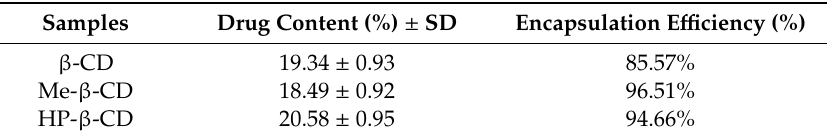
Table 1. Drug content and encapsulation e ffi ciency of solid complexes.